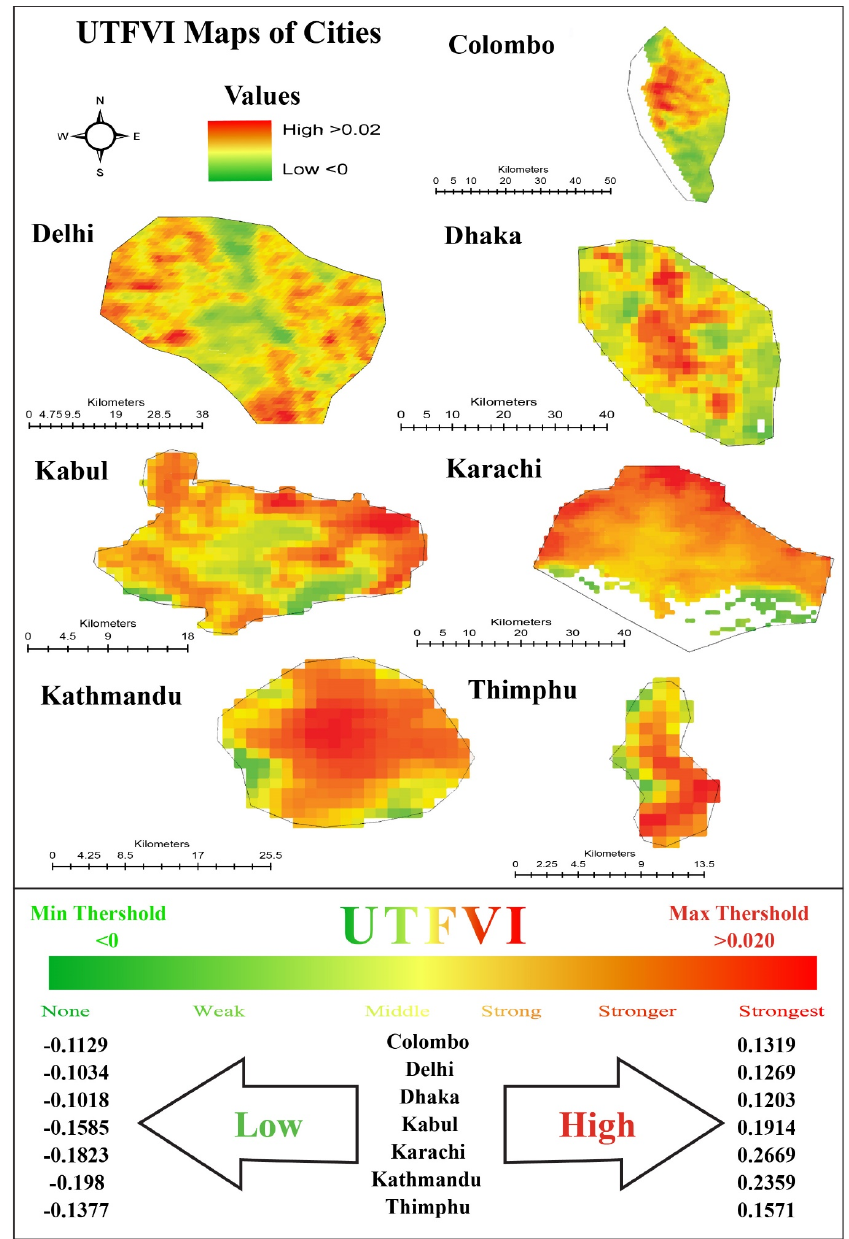
Figure 6. UTFVI Spatial trend of SA Cities .